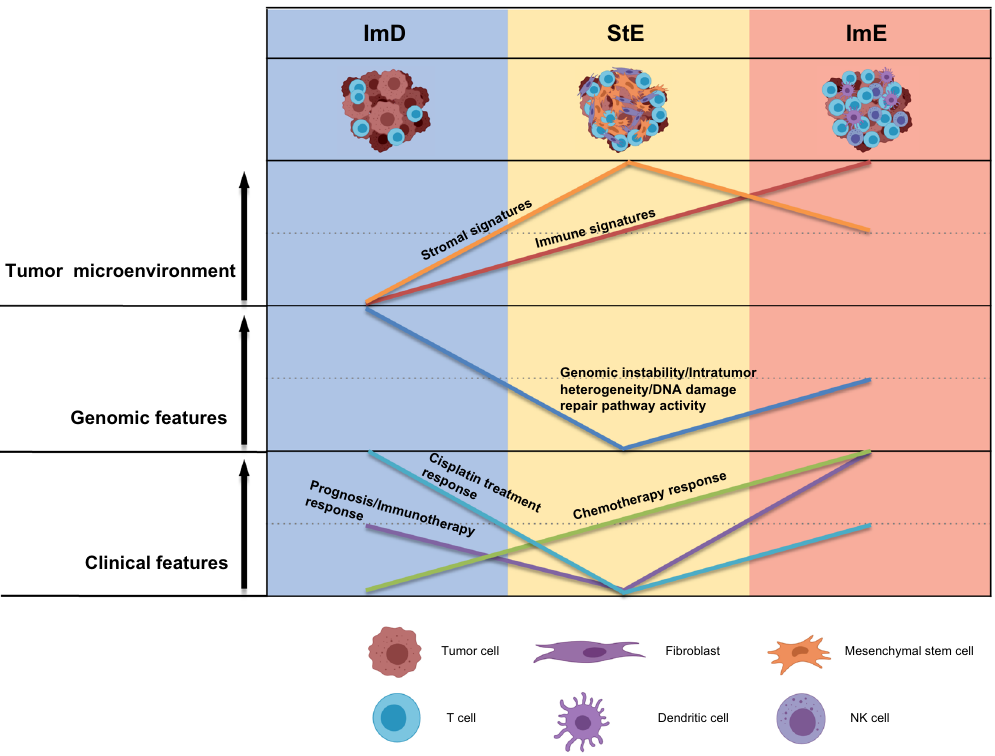
Fig. 12 A summary of molecular and clinical features of the three GC subtypes. The three GC subtypes display signi fi cantly different molecular and clinical features. The fi gure was created with